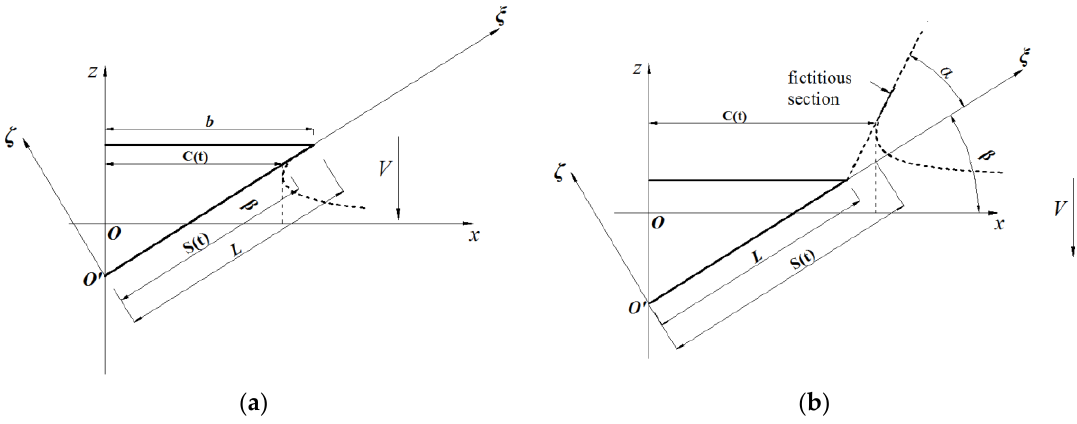
Figure 1. Impact model of a 2D wedge. ( a ) Before the flow separation; ( b ) after the flow separation.